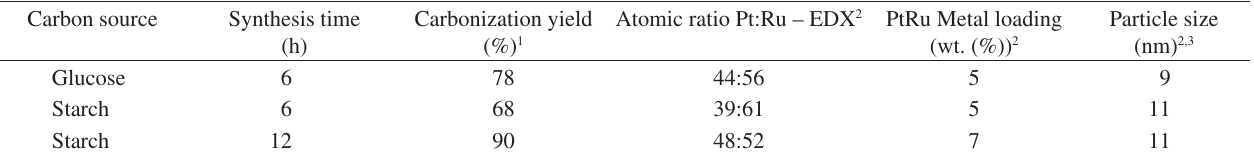
Table 1. Pt:Ru atomic ratios, average particles size and PtRu metal loading of PtRu/Carbon materials (200 °C, glucose or starch/PtRu molar ratio of 82 and Pt:Ru nominal atomic ratio of 50:50). Carbon source